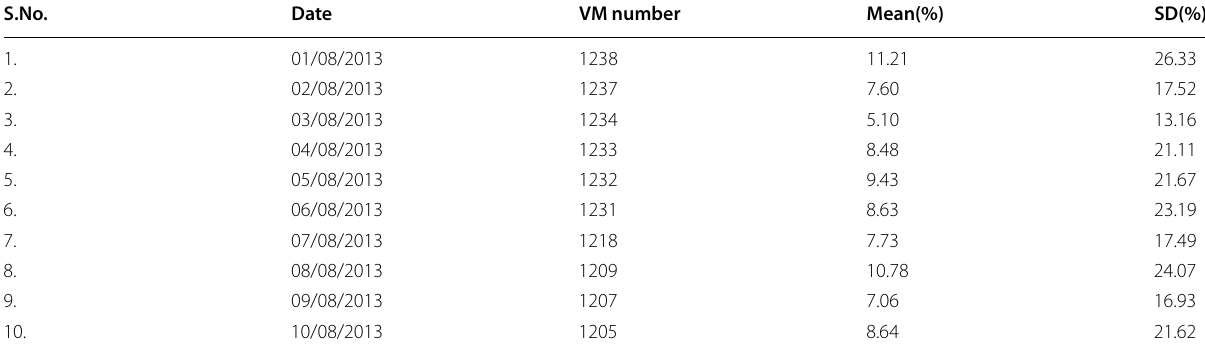
Table 10 Bitbrains workload traces have statistical properties [27]